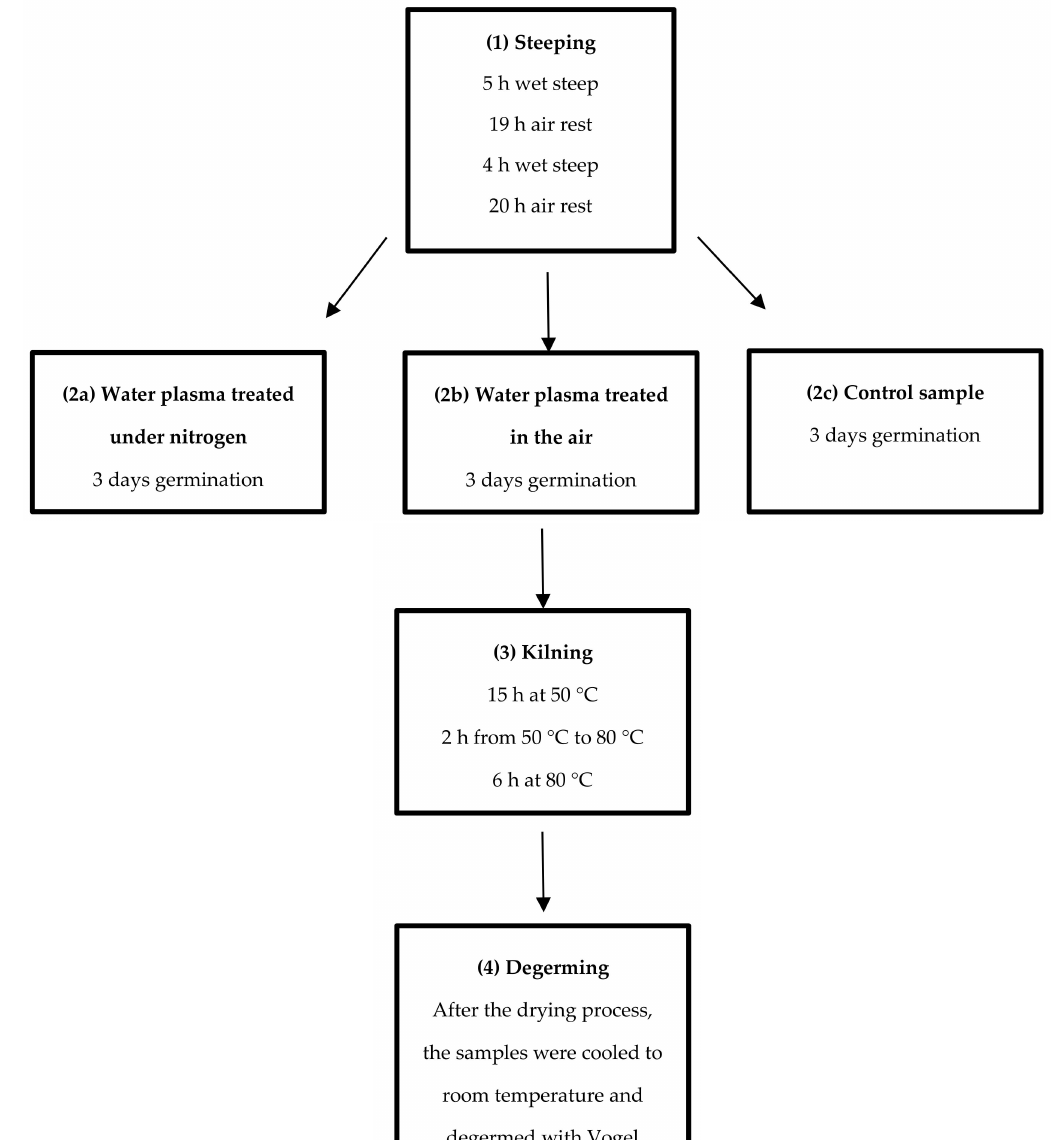
Figure 2. Malting process